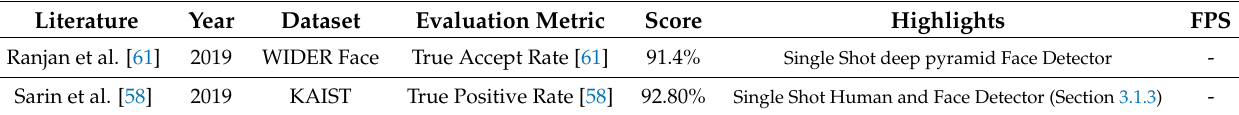
Table 4. Object detection performance: the results mentioned in this table are not directly comparable because different datasets and evaluation metrics have been